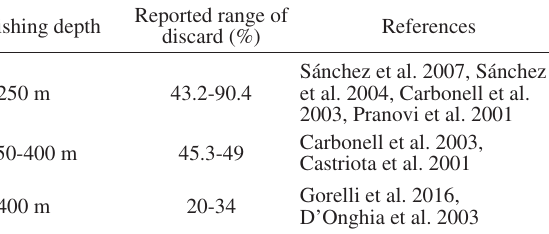
Table 9. – Reported ranges of discards by depth